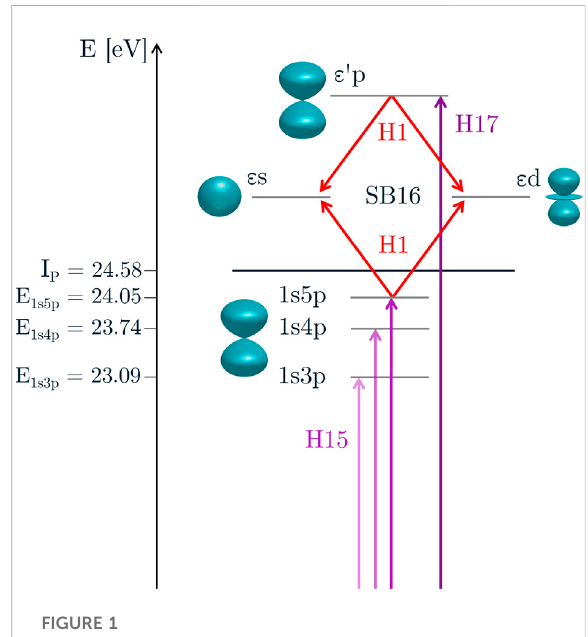
Energylevelsandexcitationprocessesinvolvedinthepresent study. The violet (red) arrows denote excitation by the 15 th and 17 th harmonics (fundamental).The spherical harmonics corresponding to the different angular momentum channels are indicated in